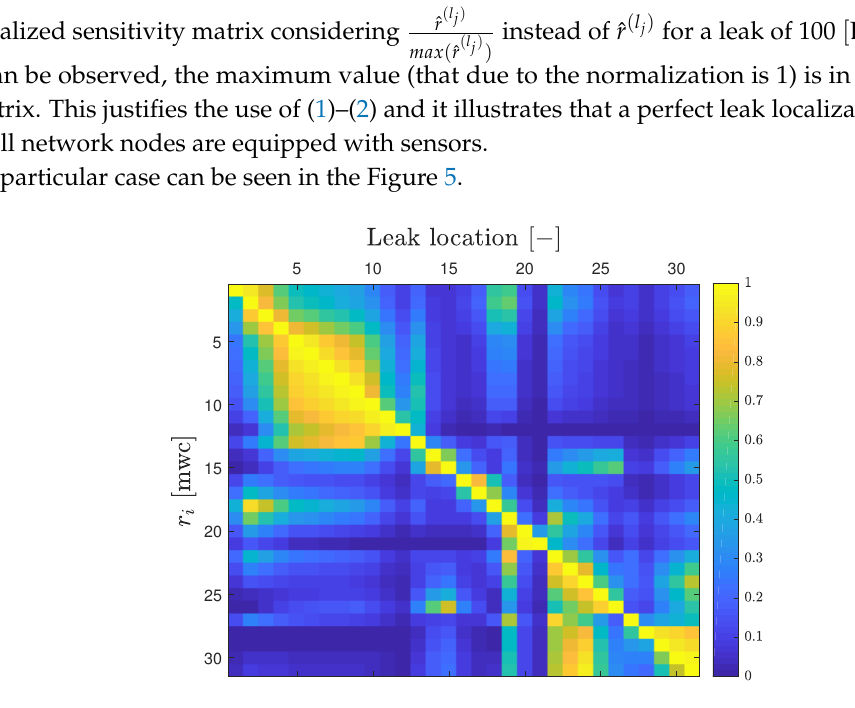
Figure 4. Normalized sensitivity matrix of the Hanoi WDN for a leak of 100 [ L/s ] considering all node pressures available.